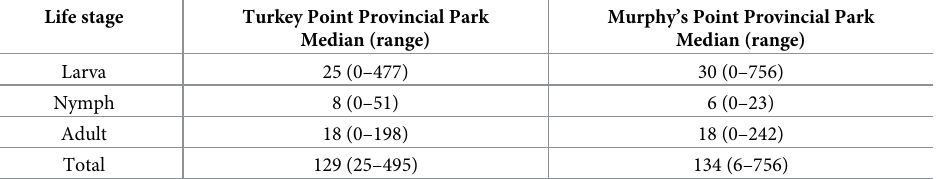
Table 1. Ixodesscapularis collected via field sampling. The median and range of each life stage of I . scapularis col- lected after three person-hours of tick dragging from May to October 2014 at Turkey Point Provincial Park and Mur- phy’s Point Provincial